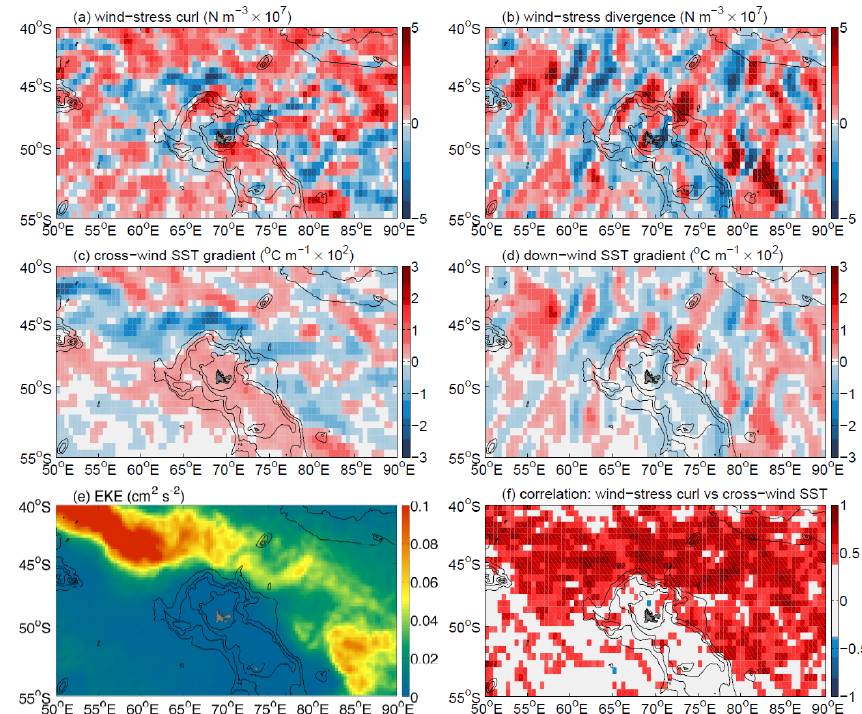
Figure 3. (a) Wind-stress curl (in Nm − 3 × 10 7 ) for December 2004 to February 2005, spatially filtered to remove large-scale signal, as discussed in the text. (b) Wind-stress divergence (in Nm − 3 × 10 7 ) for the same time period, also spatially filtered. (c) Crosswind components of the SST gradient (in ◦ Cm − 1 × 10 2 ) derived from QuikSCAT wind data and AMSR-E microwave SST. SST gradients are filtered spatially using a 10 ◦ × 30 ◦ window, averaged over the period from December 2004 to February 2005. Isobaths are plotted at 200 and at 1000m intervals. (d) Downwind component of SST gradient (in ◦ Cm − 1 × 10 2 ), computed the same way as in panel (c) . (e) Eddy kinetic energy derived from satellite altimetry, showing high eddy kinetic energy to the north of Kerguelen, along the core of the Antarctic circumpolar current. (f) Correlation between wind-stress curl and the crosswind component of the SST gradient, computed using 42 3-month samples, with consecutive samples overlapping by 1 month. White areas are not statistically significant at the 95%